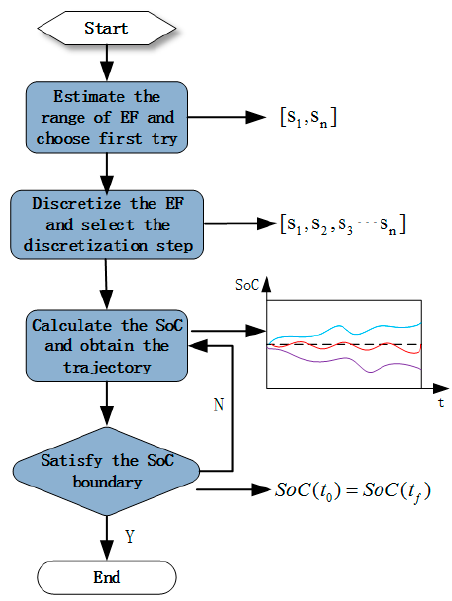
Figure 9. Iterative method to determine the initial equivalent factor (EF).